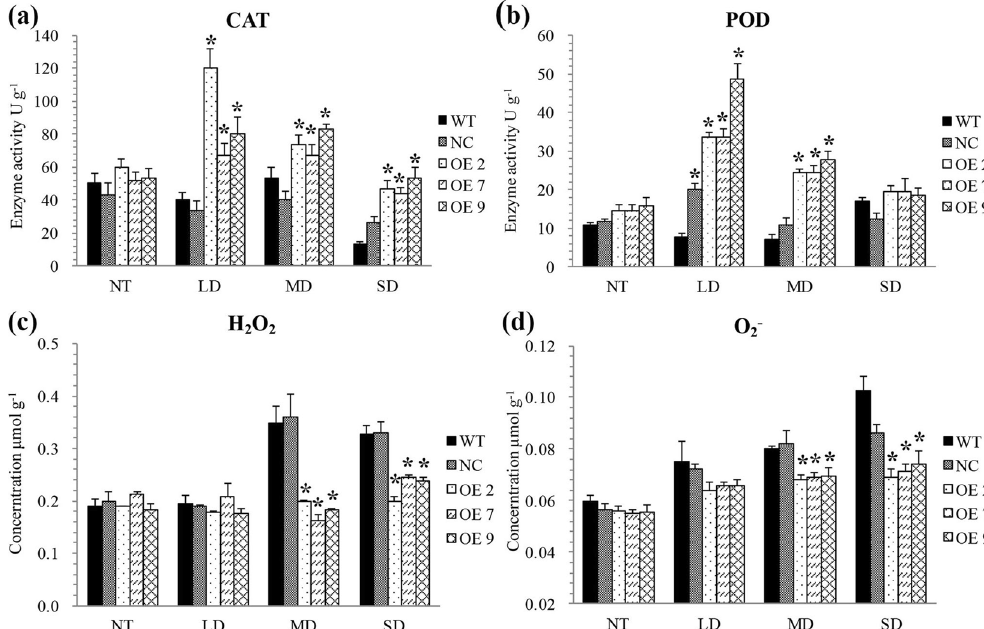
Figure 6. Changes of peroxidase (POD), catalase (CAT), H 2 O 2 and O 2 − content in 35 S::N41 (OE), wild type (WT) and NC (negative control) tobacco plants during increasing levels of drought stress, NT (non-treatment), LD (light drought), MD (medium drought), and SD (severe drought). Errors bars represented ± SD (standard